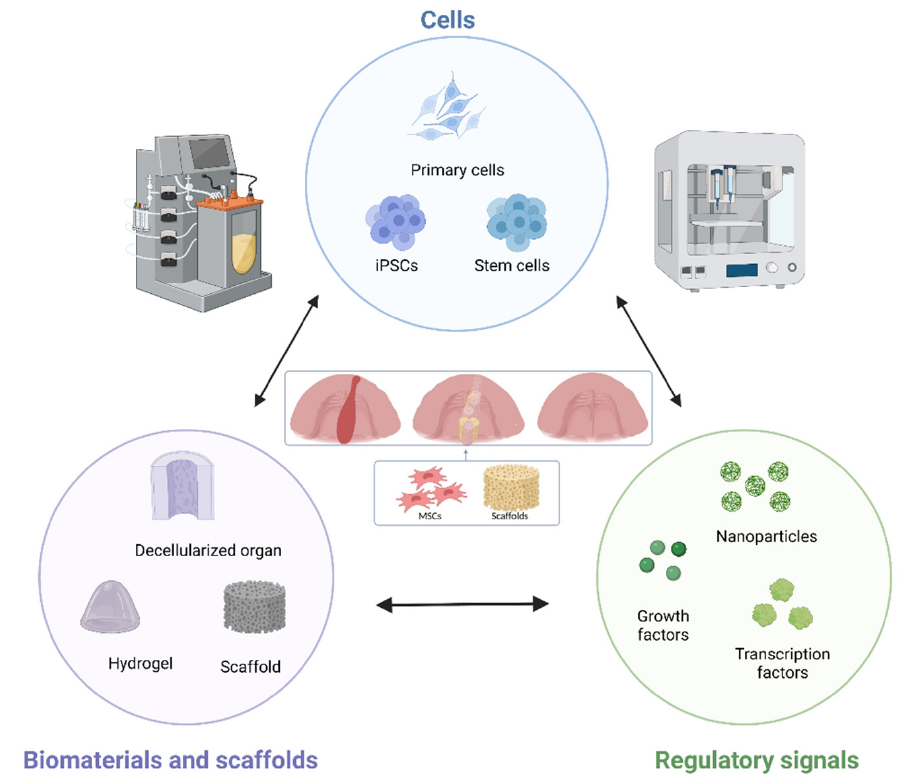
Figure 3. The essential components of tissue engineering in dentofacial malformations (cleft palate, hemifacial microsomia); stem cells, scaffolds, and regulatory signals, including GFs.